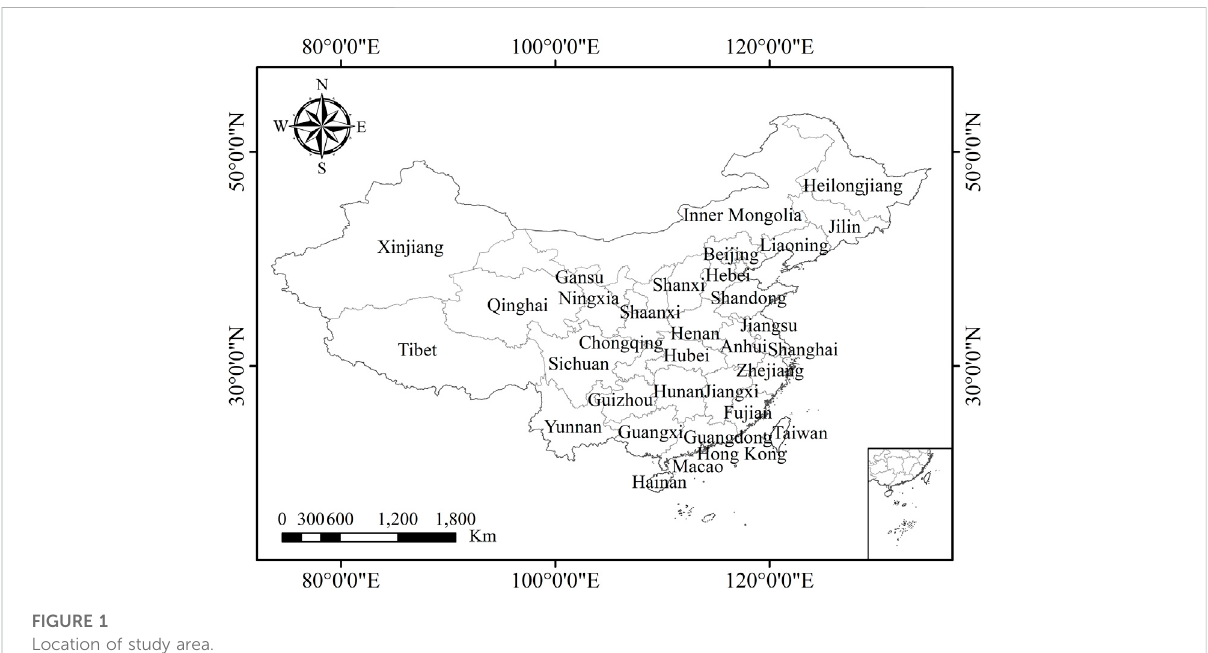
FIGURE 1 Location of study